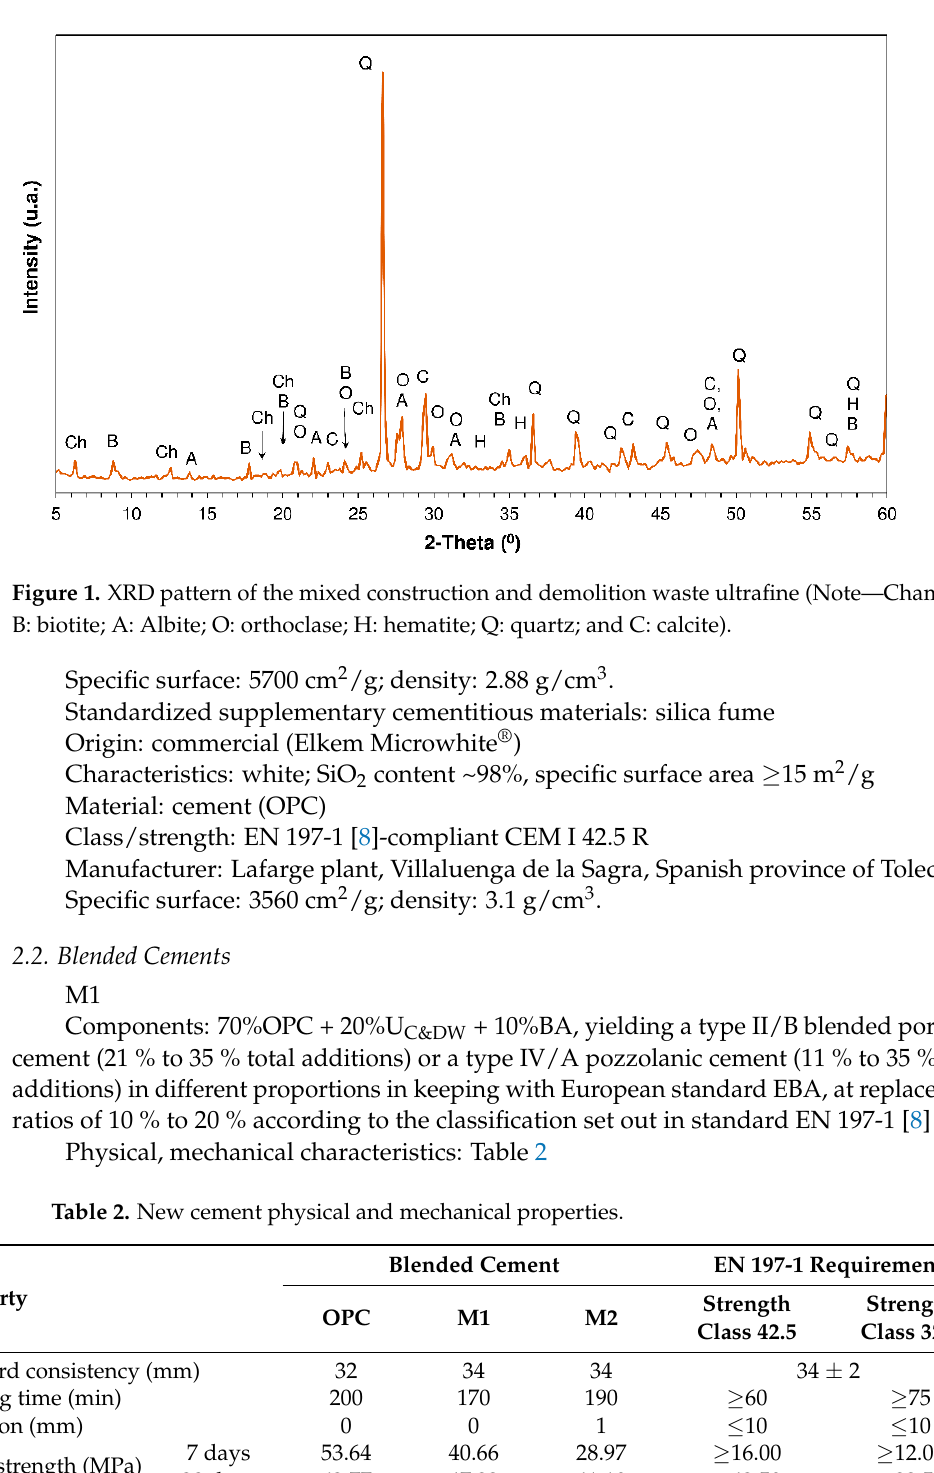
5 wt%; trace elements Mineralogical composition (figure 1): majority phases (as in other mixed C&DW re- cycled aggregates [38]) = quartz, feldspars (albite and orthoclase), phyllosilicates (chamosite and biotite) and hematite; traces of calcite.